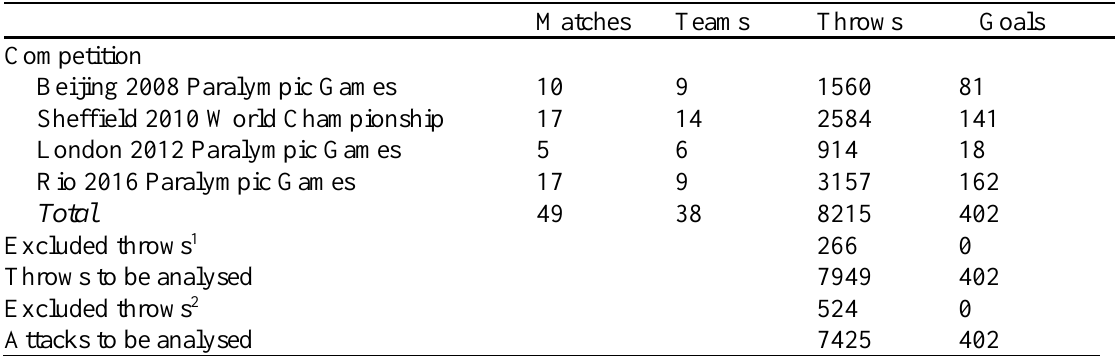
Table 1. Sample descriptive